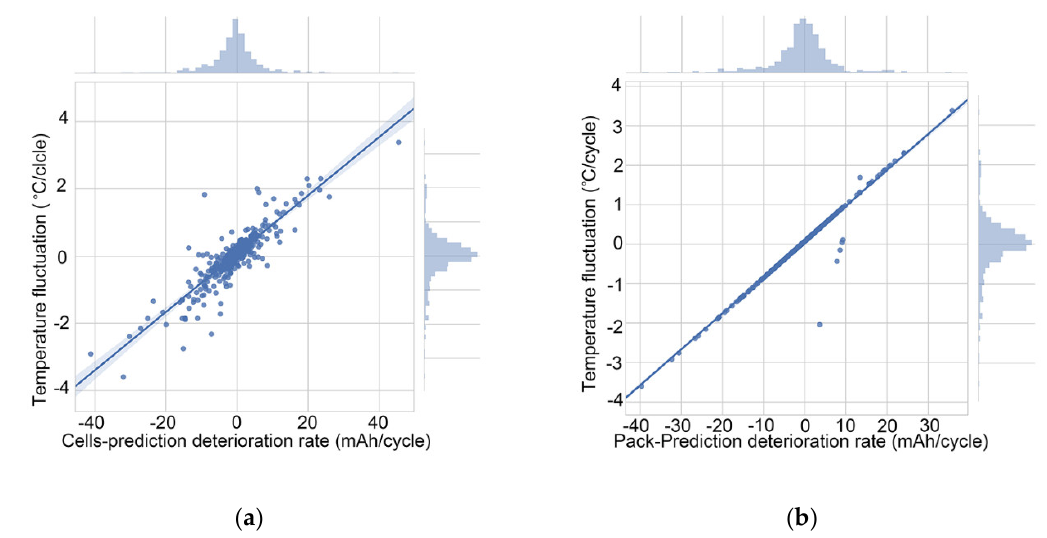
Figure 17. Correlation between the prediction degradation rate and the temperature fluctuation: ( a ) cells-prediction; ( b ) pack-prediction.